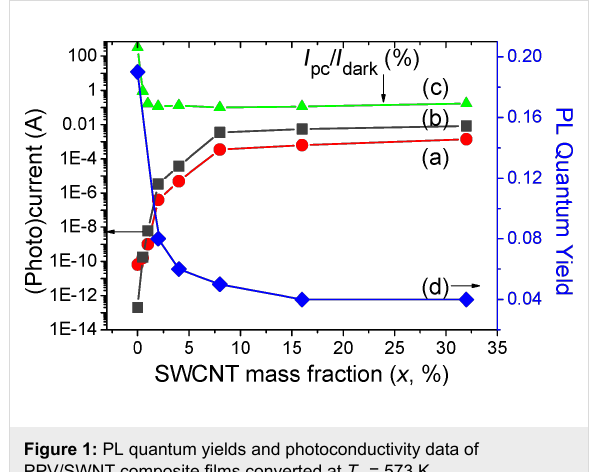
Figure 1: PL quantum yields and photoconductivity data of PPV/SWNT composite films converted at T c = 573 K. (a) photocurrent I pc = I measured − I dark ; (b) dark current I dark ; (c) ratio I pc / I dark ; (d) PL quantum